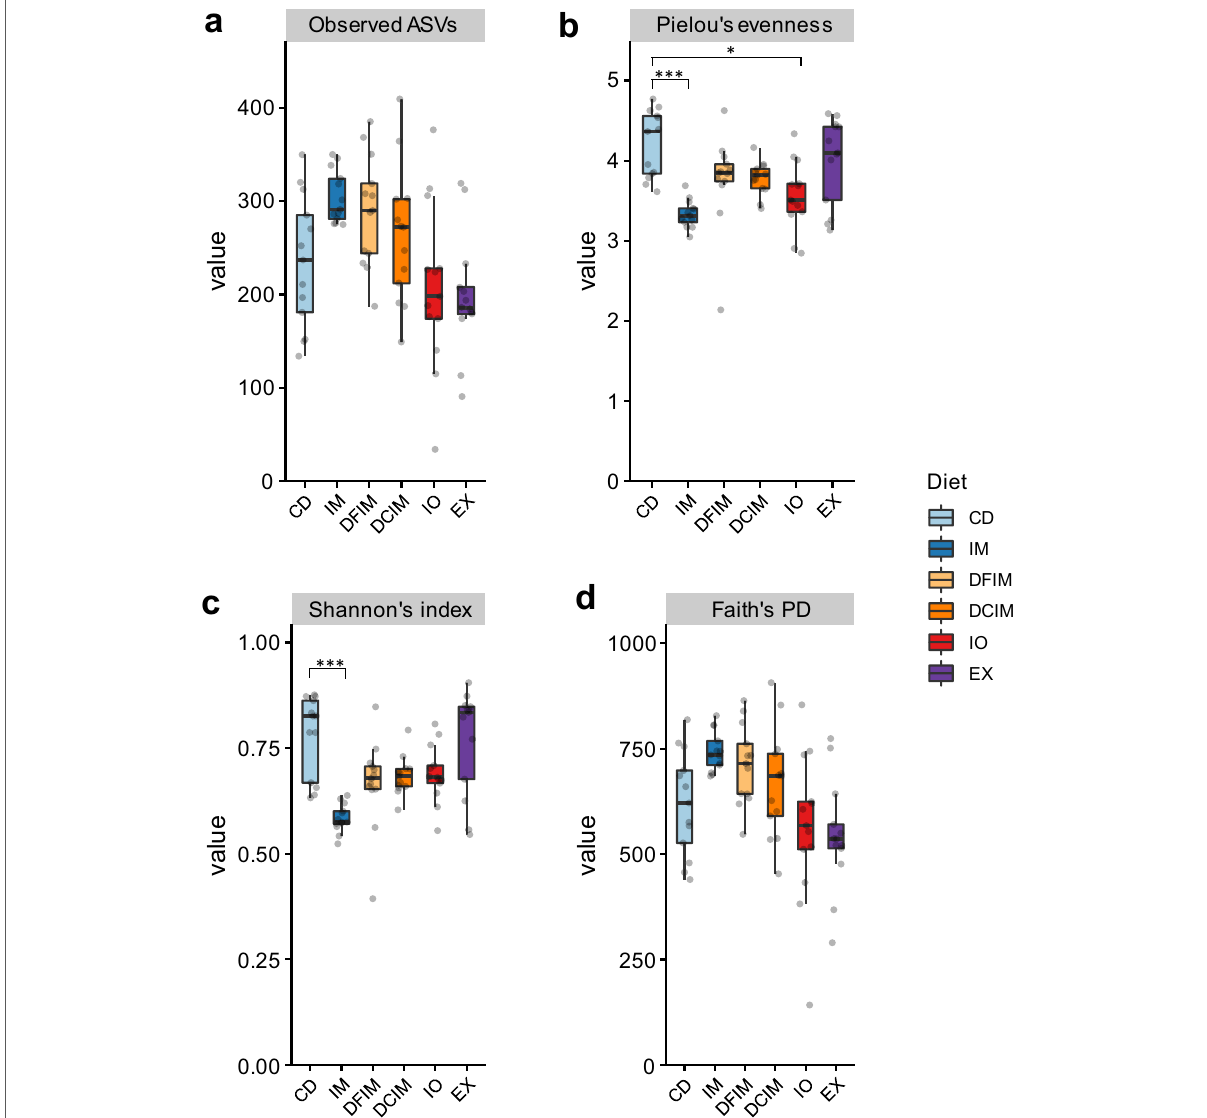
Fig. 6 The alpha-diversity of gut microbiota in salmon fed experimental diets. Observed Amplicon sequence variants (ASVs) ( a ). Pielou’s evenness ( b ). Shannon’s index ( c ). Faith’s phylogenetic diveristy (PD) ( d ). Asterisks denote statistically significant differences between control group and insect groups (* p < 0.05; *** p < 0.001). CD control diet; IM full-fat BSF larvae meal diet; DFIM defatted BSF larvae meal diet; DCIM de-chitinized BSF (black soldier fly) larvae meal diet; IO BSF larvae oil diet; EX BSF larvae exoskeleton